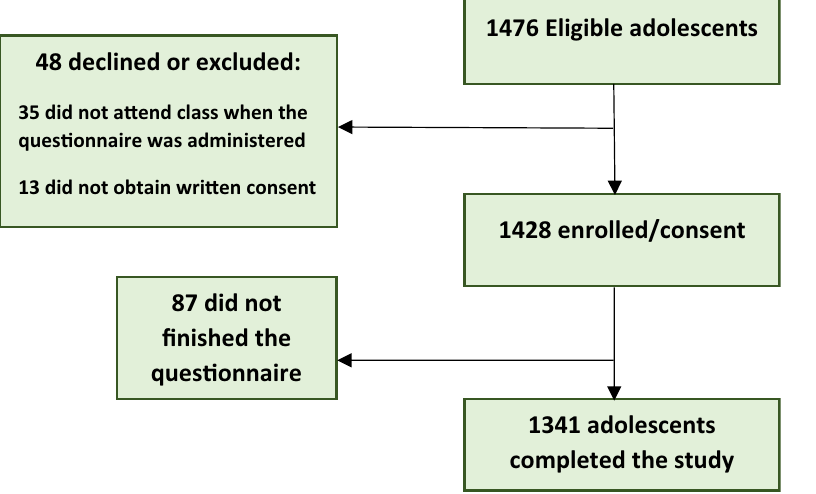
Figure 1. Flow chart of the study population.